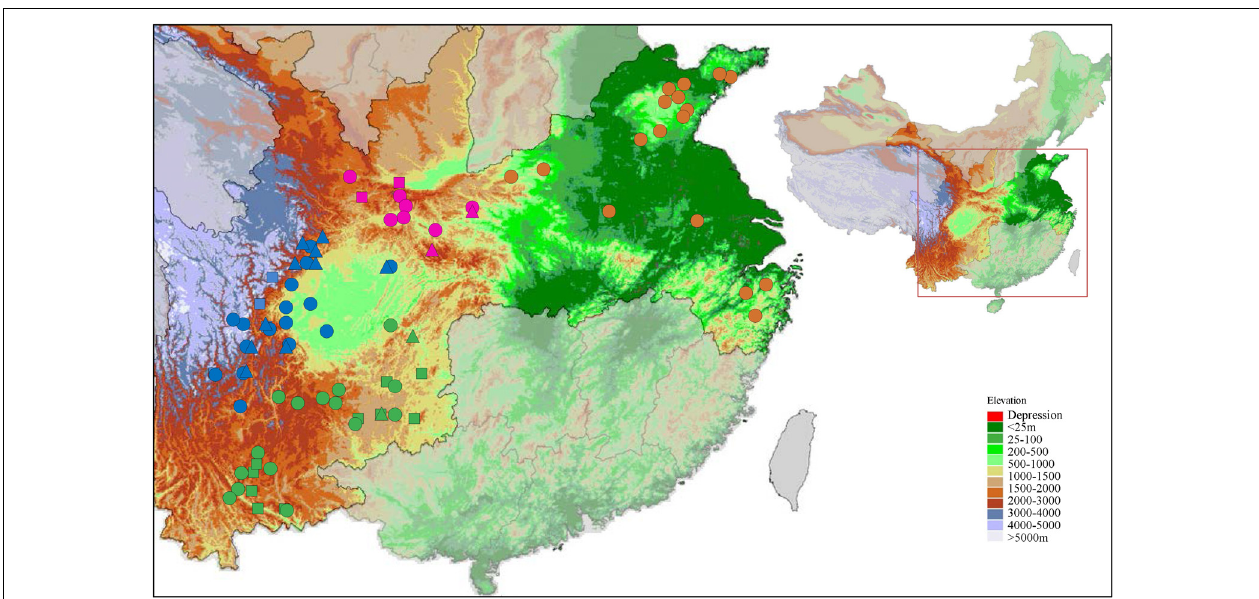
FIGURE 1 | Geographical distributions of 69 Chinese cherry populations and 17 Cerasus relative populations. All accessions are collected from natural populations in four geographical regions, including Longmenshan Fault Zones (LFZ, blue), Southwest China (SWC, green), Qinling Mountain (QLM, pink), and North and East China (NEC, orange). The cultivated, wild and Cerasus relative populations are colored according to their geographical distributions, and also are represented by circles, triangles, and squares,